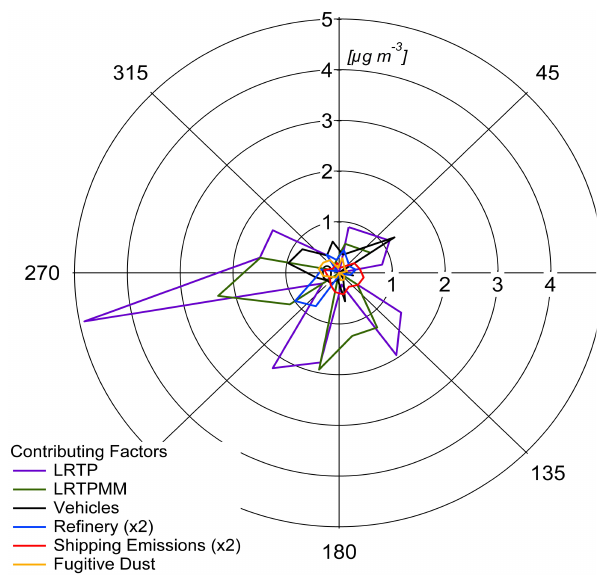
Fig. 10. Source contribution